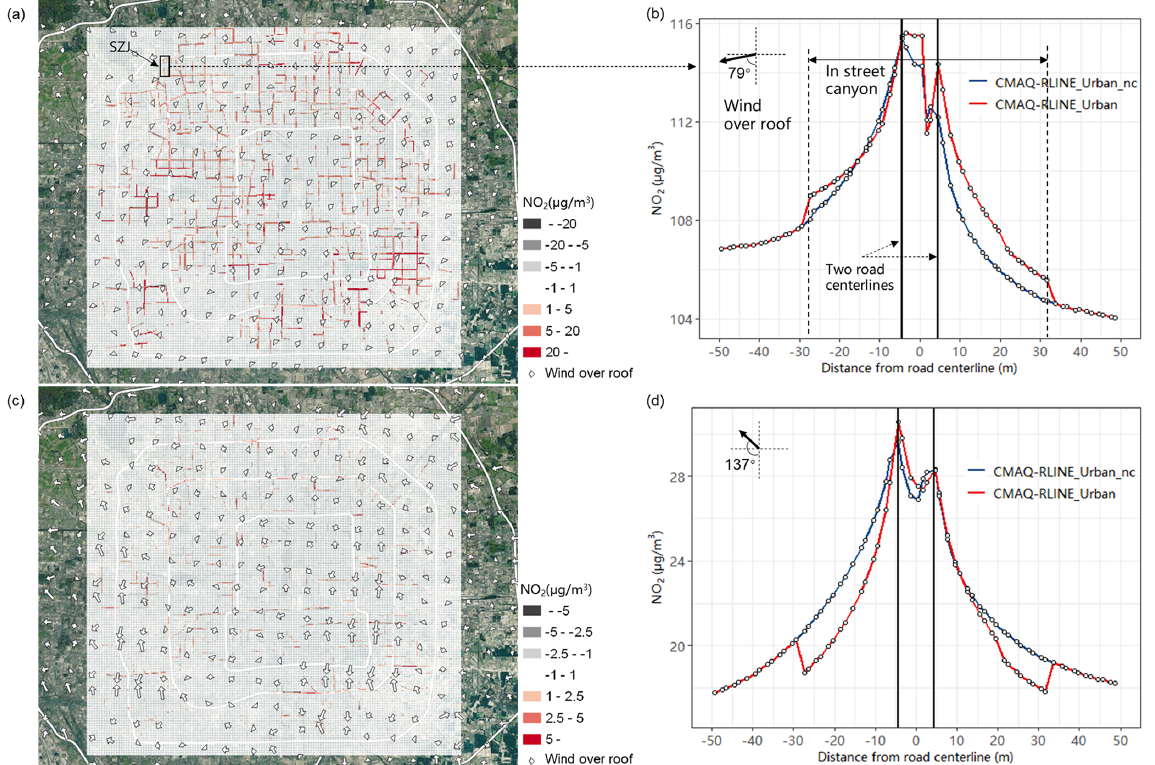
Figure 8. Differences in NO 2 concentrations at the height of 1.5m impacted by the MLSCF scheme (a, c) over the study domain (CMAQ- RLINE_URBAN – CMAQ-RLINE_URBAN_nc) (© Microsoft) and (b, d) near SZJ in 24 August 2019 at 00:00–01:00 (a, b) and 10:00– 11:00 (c, d)